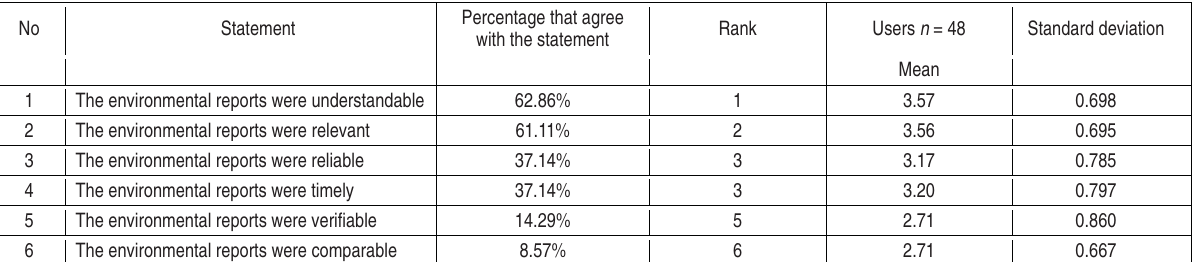
Table 4. Users’ perception of the quality of environment reports